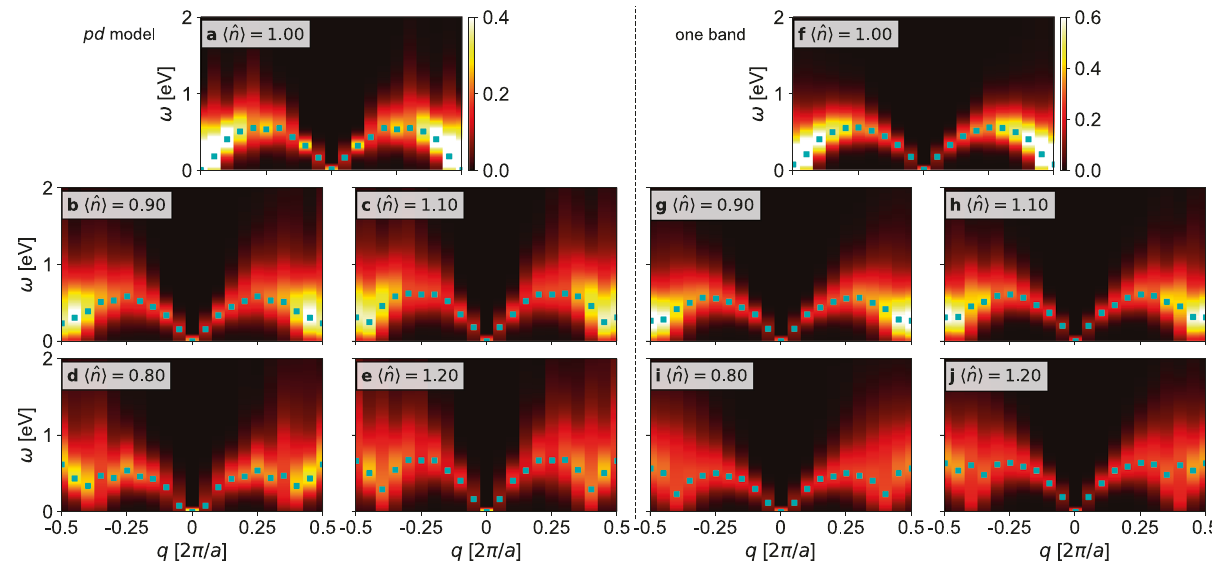
Fig. 4 Finite temperature determinant quantum Monte Carlo (DQMC) results for the total dynamical spin structure factor S ( q , ω ) of the multi-orbital pd - and single-band Hubbard models. Panels a − e show the dynamical spin structure factor S ( q , ω ) as a function of momentum q and energy ω , obtained from DQMC simulations of the multi-orbital model with a Cu − O basis (the pd -model) at various fi llings h ^ n i , as indicated. The parameters for the pd -model include the onsite energies ϵ d = 0, ϵ p , x = 3, and ϵ p , y = 3.5, the hopping integrals ∣ t ( p , x ) d ∣ = 1.5, ∣ t ( p , y ) d ∣ = 1.8, and ∣ t pp ∣ = 0.75, onsite Hubbard interactions U = 8 and U = 4, and the interorbital Hubbard interaction U = 1, in units of eV. Panels f − j show corresponding results for DQMC simulations of the d p pd single-band Hubbard model with nearest-neighbor hopping t = 0.5 eV, next-nearest-neighbor hopping t 0 ¼ 0 : 06 t ¼ 0 : 03 eV, and an onsite Hubbard interaction U = 5.32 t = 2.66 eV. Both sets of results were obtained using chains with N = 20 unit cells and at temperature T = 0.0625 eV.